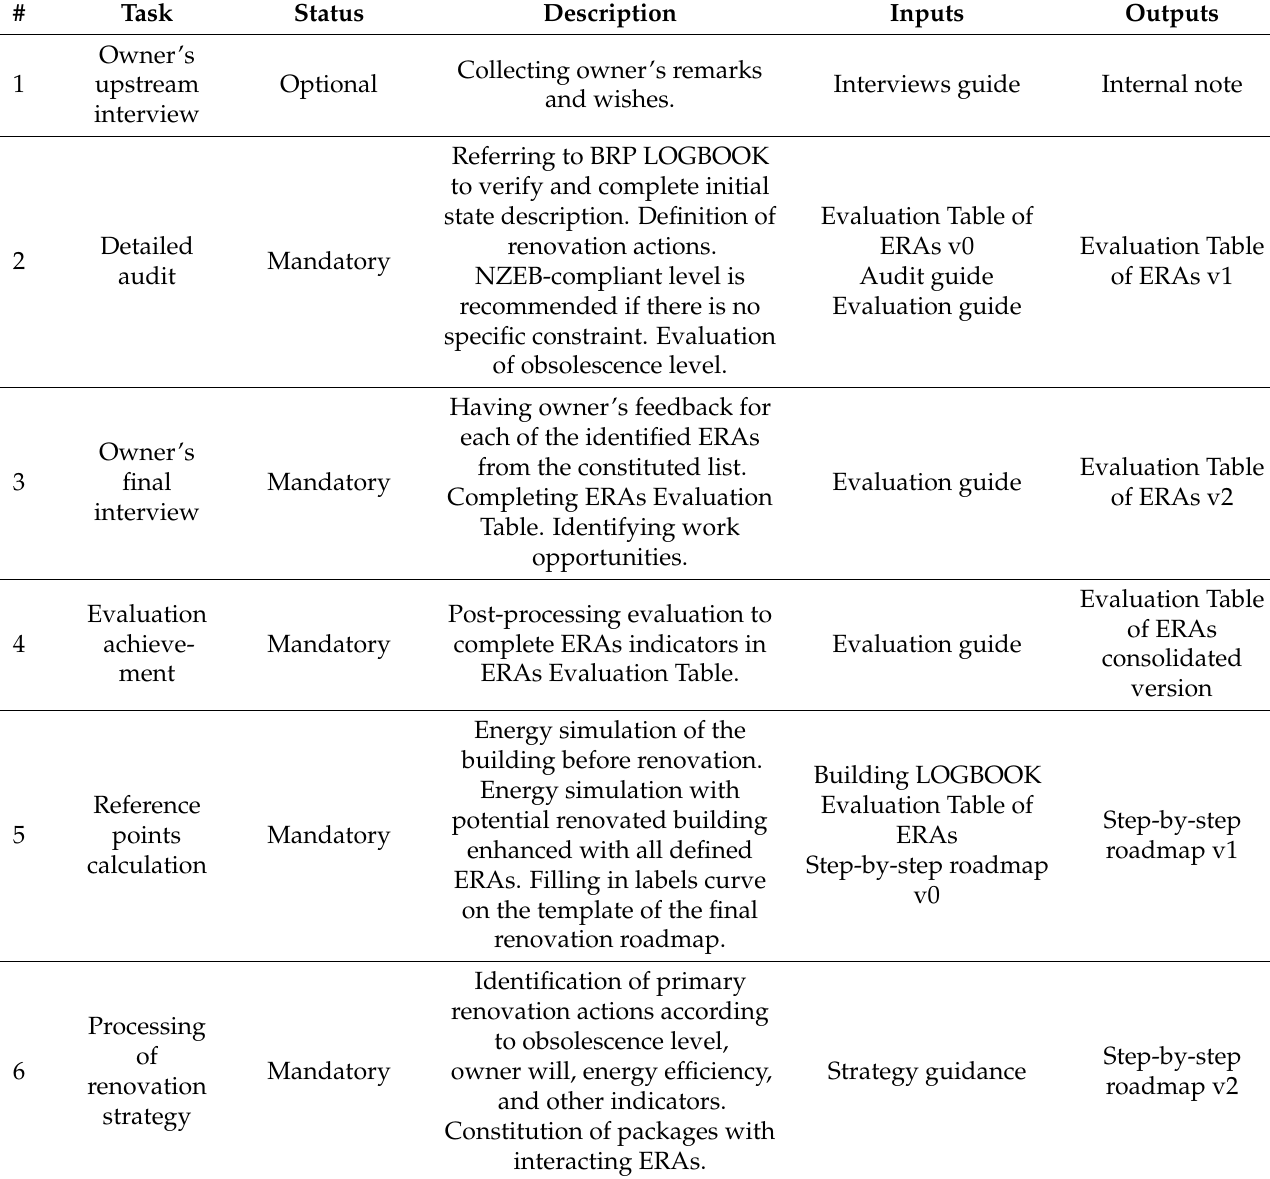
Table 5. Summary of the ALDREN RenoMap protocol